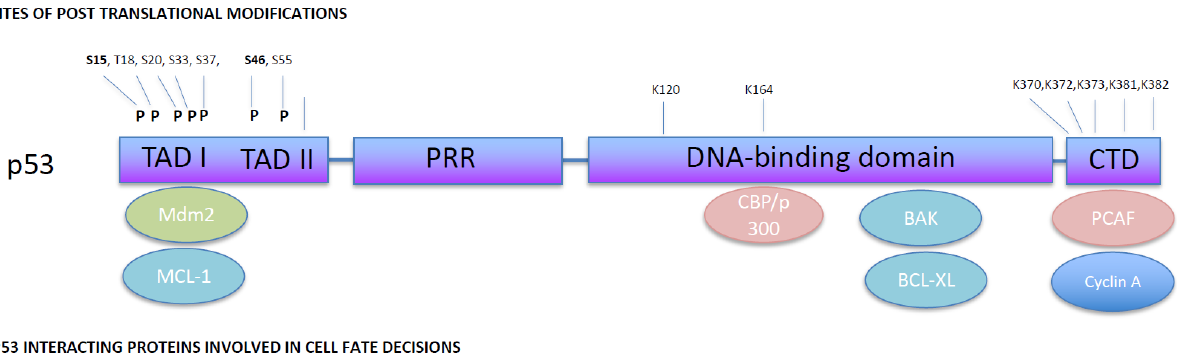
Figure 2. Schematic representation of p53 domain structure and selected interactions with pro- teins involved in cell fate decisions. p53 has two transcriptional activation domains (TAD I, residues 20–40 and TAD II, residues 40–60), a proline-rich region (PRR, residues 60–90), core DNA- binding domain (DNA-binding core, residues 100–300) and the C-terminal domain (residues 301–393). p53 has multiple post-translational modifications, including phosphorylation (P) or ubiquitination (Ub) on Lysine residues, affecting the cell fate outcome in response to p53 activation. Additionally, p53 interacts with specific proteins involved in cell fate, which also influences the cell fate outcome.